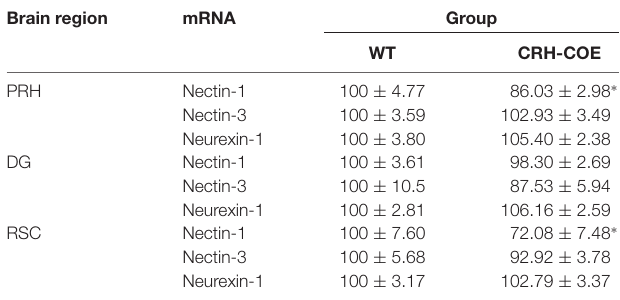
TABLE 2 | The mRNA expression levels of nectin-1, nectin-3 and neurexin-1 in adult wild-type (WT) and corticotropin-releasing hormone conditional overexpression (CRH-COE)